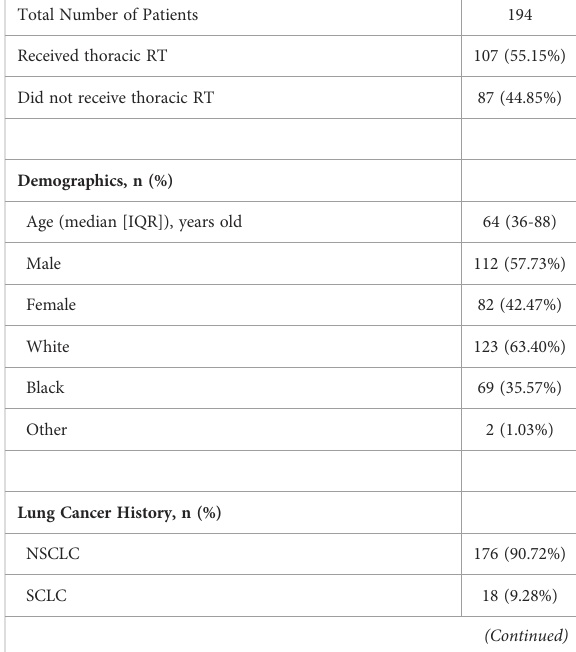
TABLE 2 Baseline patient characteristics include demographics, cancer history, co-morbidities, cardiac medical history, and medications prior to initiation of